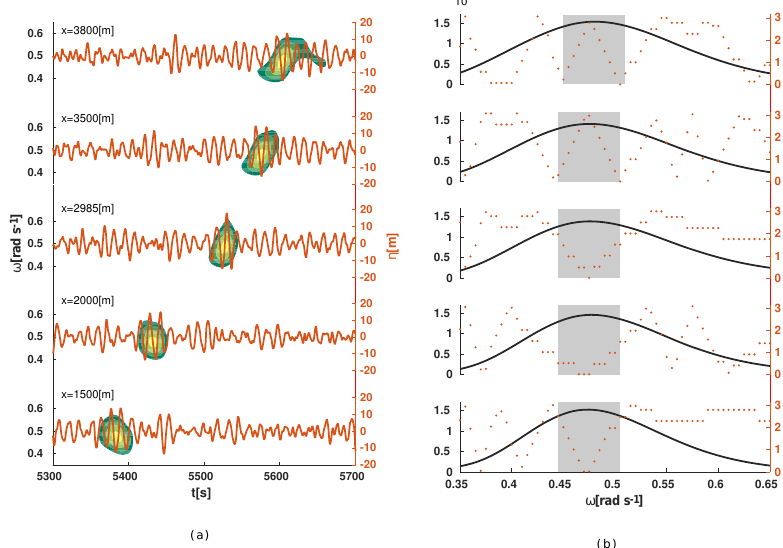
Figure 18. Case TS10000. (a) Time signals at various positions of the evolution of the critical group event with the filled contour plot of wavelet spectra. (b) The corresponding time-averaged wavelet spectra (solid line) and the time spreading (dotted line). The shaded areas show the chosen frequency interval of the most energy-carrying modes.